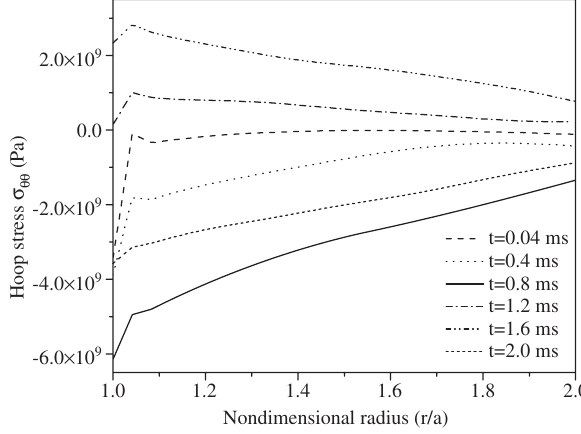
Figure 8 Response histories of hoop stress in the FGM hollow cylinder at different thicknesses, where n = 1.